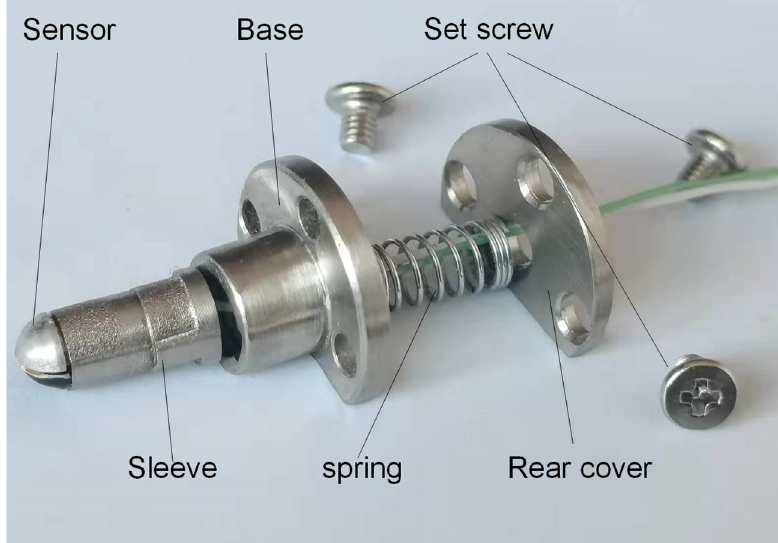
Figure 7. Adaptive thin-film temperature sensor.